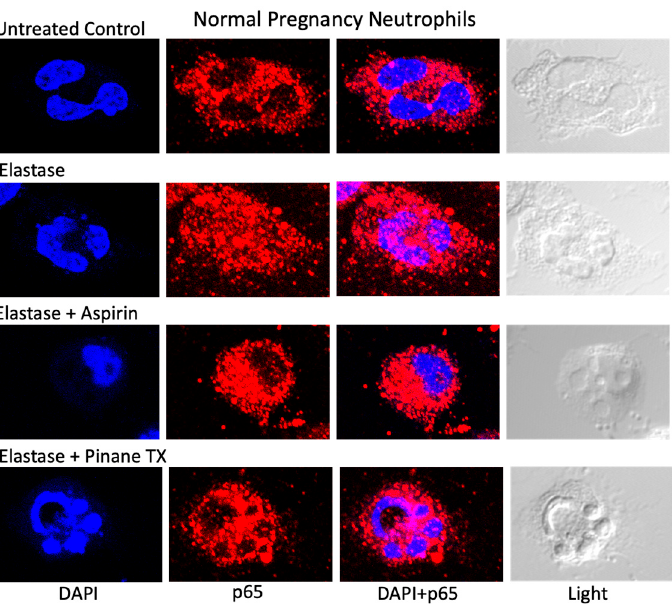
Figure 1. Confocal microscopy images. Red fluorescence, the p65 subunit of NF- κ B; DAPI blue lo- cation of nucleus. x63 lens.